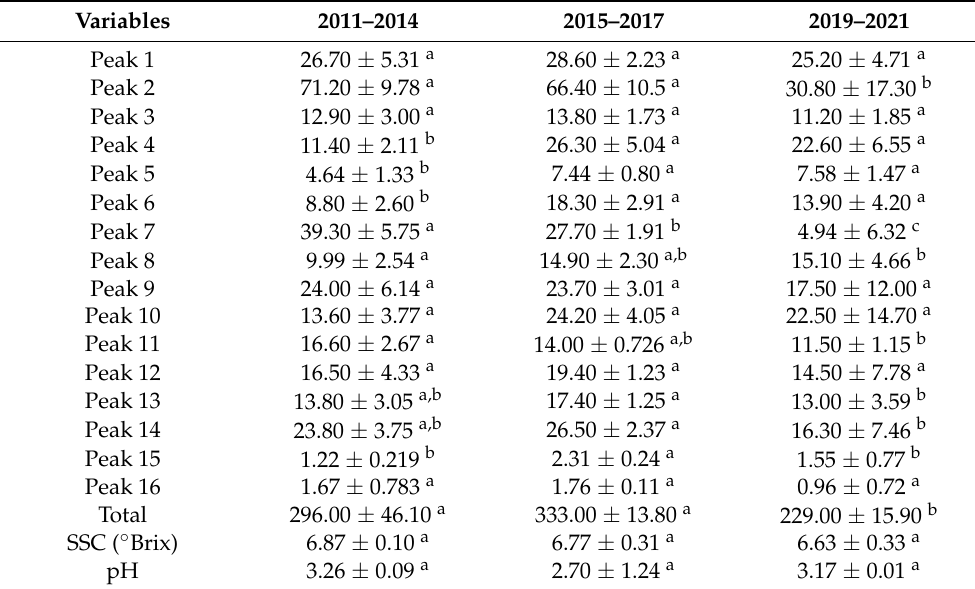
Table 5. Mean and standard deviation of the physiochemical and polyphenol content according to the three clusters, expressed as mgGAE/L (peak 1–7), mgPAE/L (peak 8–14), and mgFAE/L (peak